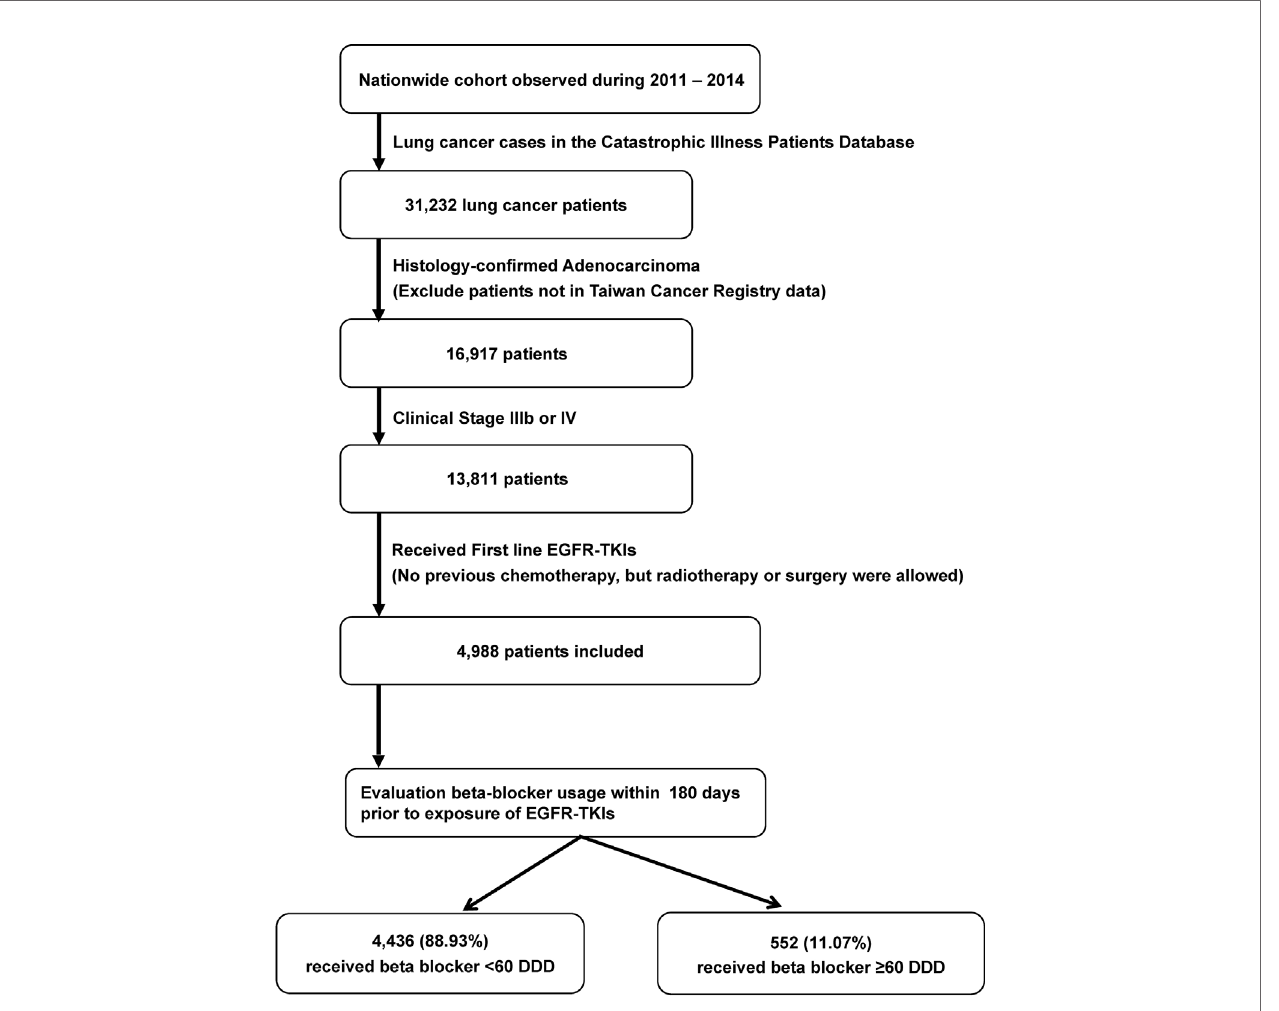
FIGURE 1 | Selection and disposition of the study subjects. EGFR-TKIs, epidermal growth factor receptor tyrosine kinase inhibitors; DDD, de fi ned daily